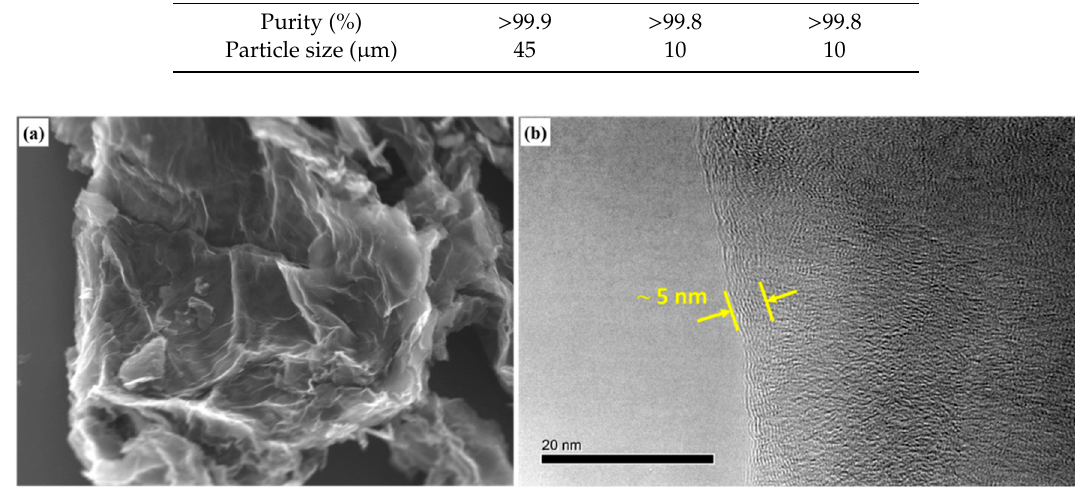
Figure 1. Characteristics of GNPs: ( a ) TEM image of GNPs; and ( b ) SEM image of GNPs.